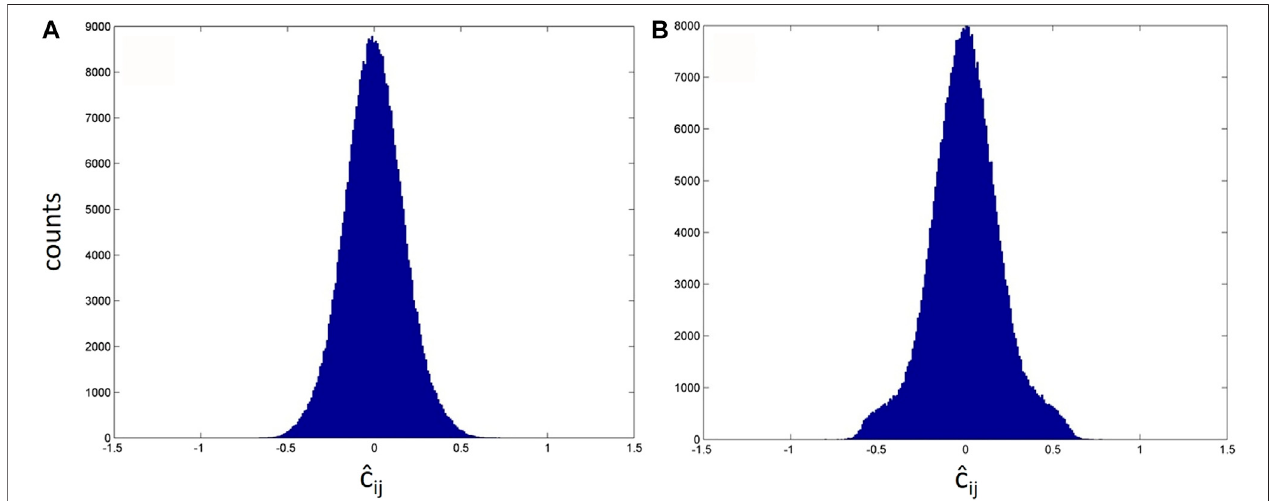
FIGURE 5 | Histograms of cross-correlation value distributions between event templates and noise data where infrasonic tremor is fi ltered out (A) , and with presence of infrasound tremor (B) .